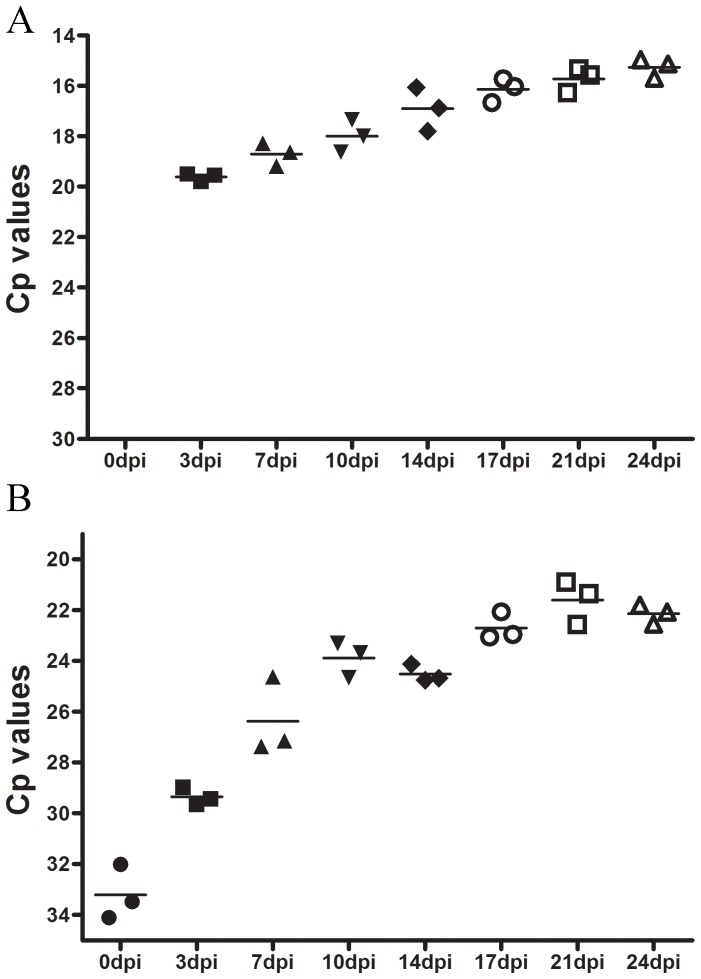
Virus replication expressed as Cp values at different times after infection of GF-1 cell cultures.A) Cell-associated compartment. No detectable virus genome was found at 0 dpi. Samplings 0–14 dpi: Significant changes between all samplings separated one week or more in time (P<0,001–0,05), 14 dpi: significant change to 24 dpi (P<0,05). B) Supernatant. Samplings 0–7 dpi: Significant changes compared to all samplings in the study (P<0,001–0,01), 14 dpi: significant change to 21 (P<0,01) and 24 dpi (p<0,05) (One way ANOVA). The cells were washed after 4 h of incubation with virus, and samples were collected sequentially, as indicated, post infection. The 0 h time point is the first sampling after incubation and washing. The experiment included three parallels at each time point (n = 3).